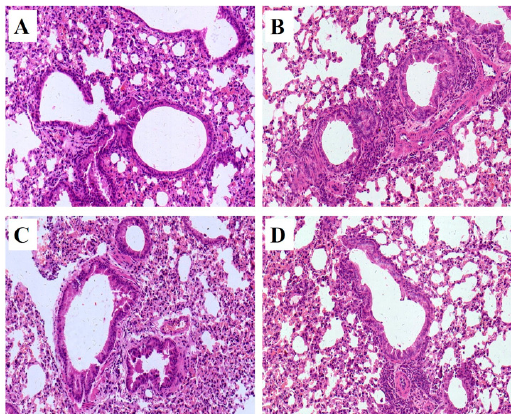
Figure 2. Example of pathological changes of the lung tissue observed by Hematoxylin and Eosin (HE) staining (Light microscopy, ×400): ( A ) (control); ( B ) (model); ( C ) (Dexamethasone (2 mg·kg − 1 )); ( D ) (mKG (9.7 g·kg − 1 )).